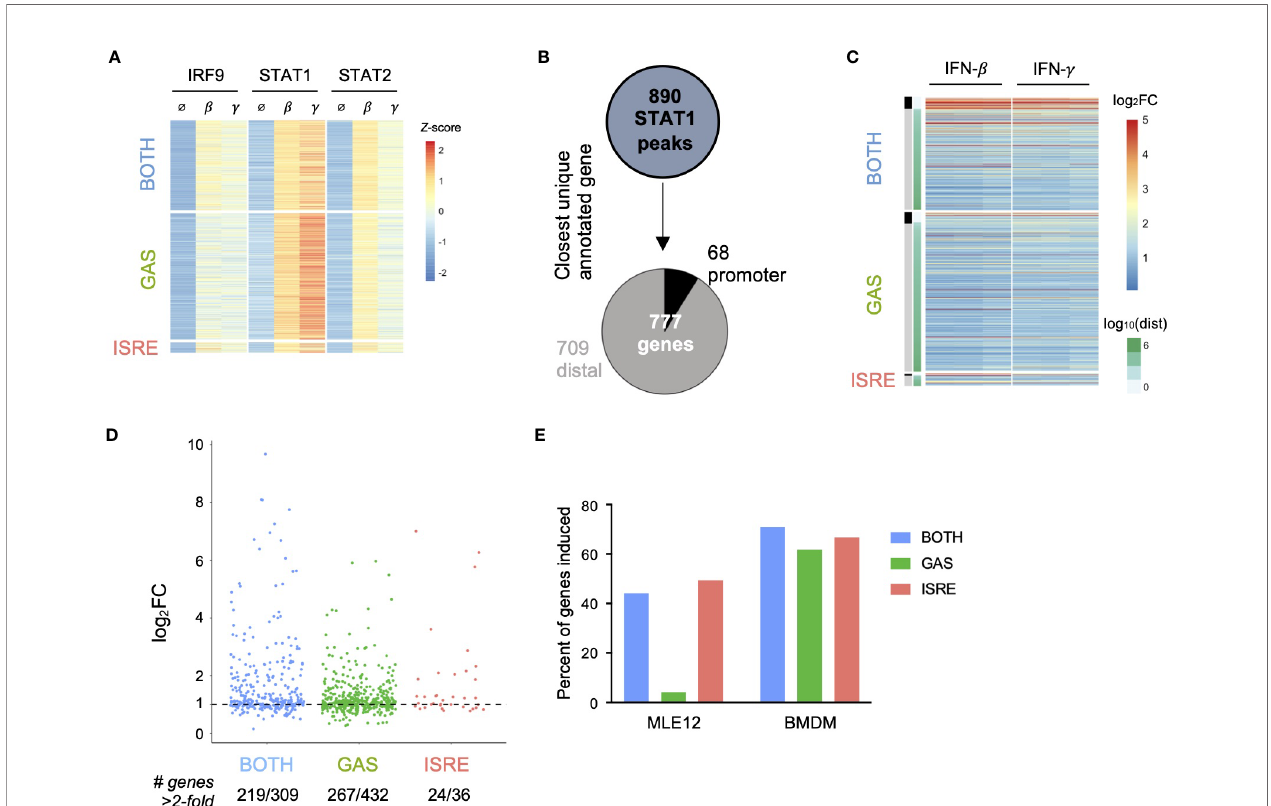
FIGURE 4 | In macrophages, GAF does induce expression of nearby genes. (A) Heat map of ChIP-seq data in macrophages (21), categorized by presence of GAS or ISRE motif. (B) Schematic for linking peaks to genes in macrophages. Promoter de fi ned as -1000 to +100 bp from TSS. (C) Heat map of log2 fold-change of macrophage genes linked to macrophage STAT1 peaks. Three replicates of 2-hour stimulation with IFN. Genes are ordered by distance to STAT1 peak. (D) Dot plot of genes in each category showing number of macrophage genes above 2-fold induction threshold. (E) Bar graph of the percentage of genes near motif-categorized peaks that are induced upon IFN- b stimulation, comparing MLE12 cells vs.